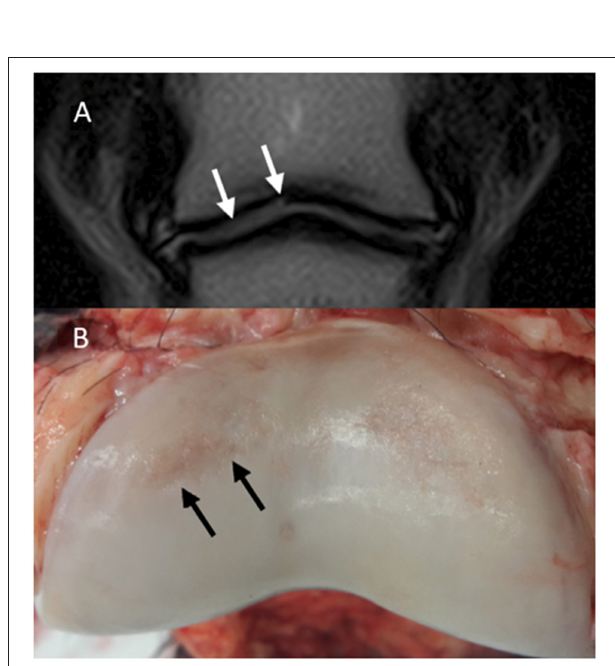
FIGURE 5 | Magnetic resonance (MR) and macroscopic images of the same horse. Lateral is to the left; (A) Dorsal T2-weighted FSE. A hyperintensity is noted in the lateral aspect of the articular cartilage of the middle phalanx (P2) (white arrows). (B) Gross appearance of P2. There are cartilage erosions in the dorsolateral (black arrows) and dorsomedial aspects of the articular surface. The cartilage defect on the dorsomedial aspect appears more superficial compared to the dorsolateral aspect and could not be identified in MR